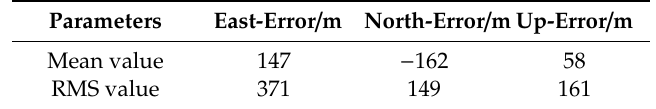
Table 1. Error statistic results of positioning with the ring alert signal in weak signal environment.